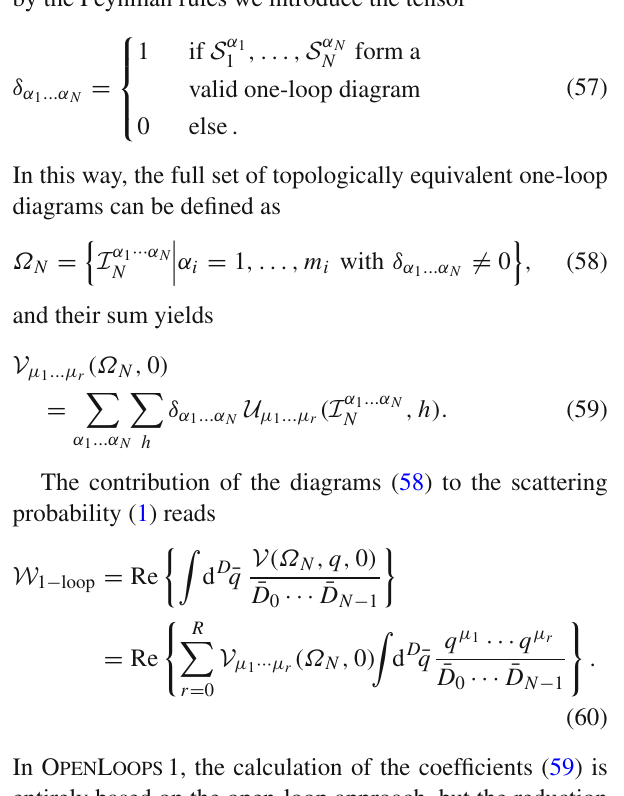
α i and/or loop vertices v i